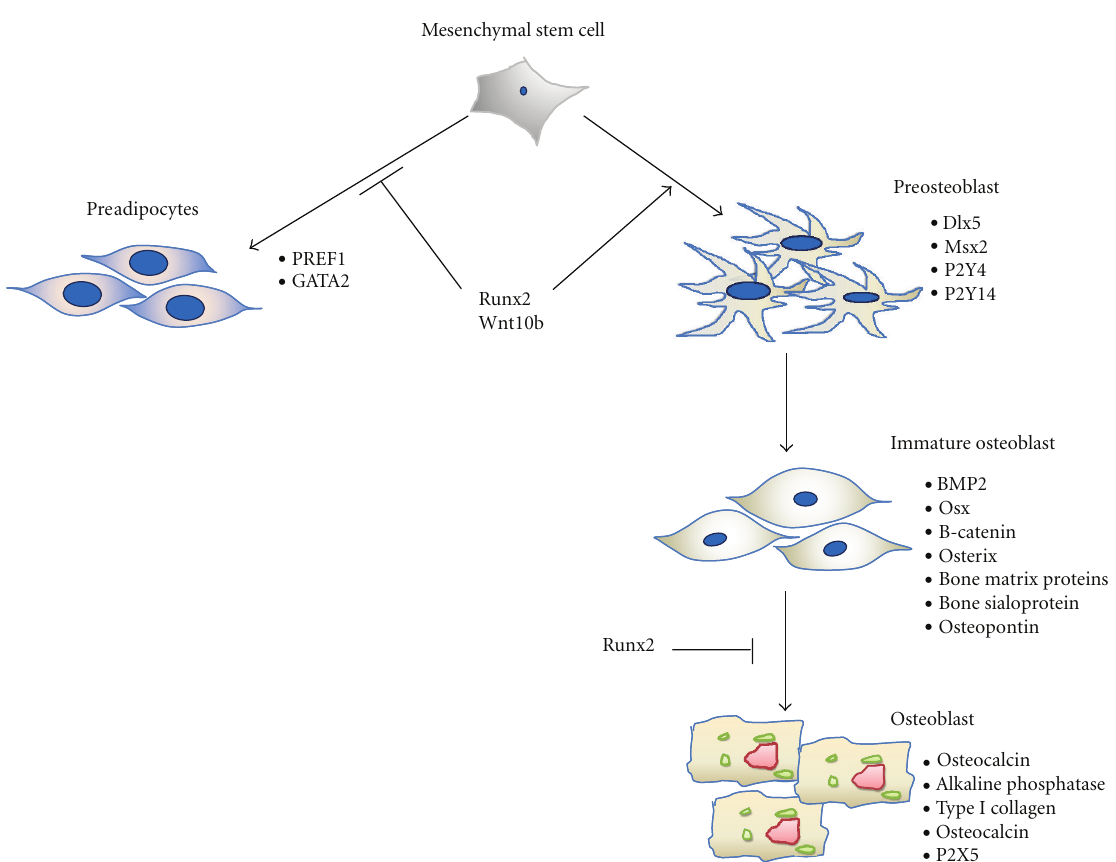
Figure 2: Change and di ff erentiation of mesenchymal stem cells towards osteoblasts. Runx2 commits MSCs towards osteogenic lineage and inhibits adipogenic di ff erentiation. After commitment, MSCs are di ff erentiated into preosteoblasts which express runt-related transcription factor 2 (Runx2), distal-less homeobox 5 (Dlx5), and msh homeobox homologue 2 (Msx2). Preosteoblasts di ff erentiate into immature osteoblasts. Immature osteoblasts express bone morphogenetic protein 2 (BMP2), Osterix (Osx), β -catenin, bone matrix proteins, bone sialoprotein, osteopontin and develop into mature osteoblasts. Mature osteoblasts express osteocalcin, alkaline phosphatase, and type I